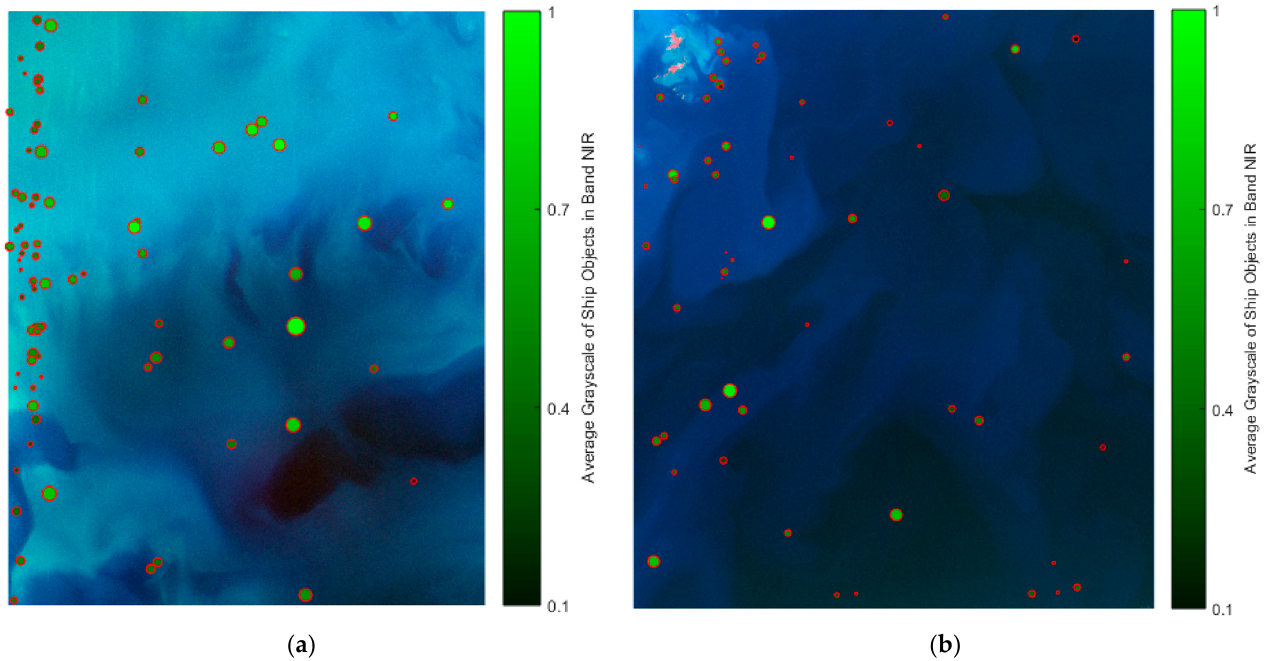
Figure 9. Visual e ff ect of fi nal ship detection in two regions of interest (ROIs): ( a ) result of ROI1; ( b ) Figure 9. Visual effect of final ship detection in two regions of interest (ROIs): ( a ) result of ROI1; result of ROI2. ( b ) result of ROI2.